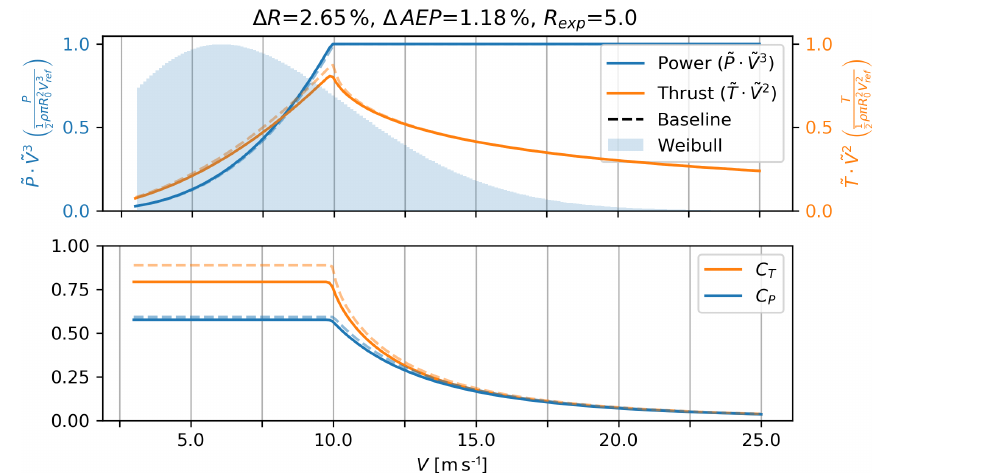
Figure 8. Power and thrust curves for rotor with the DDLC exponent R exp = 5 (solid lines), corresponding to a δ tip constraint. The dashed line is the baseline rotor optimized for max C P .